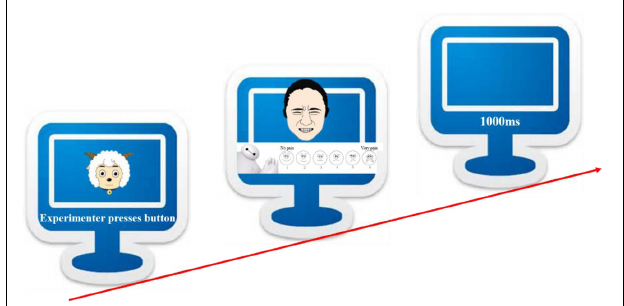
FIGURE 6 | Pain evaluation task diagram.